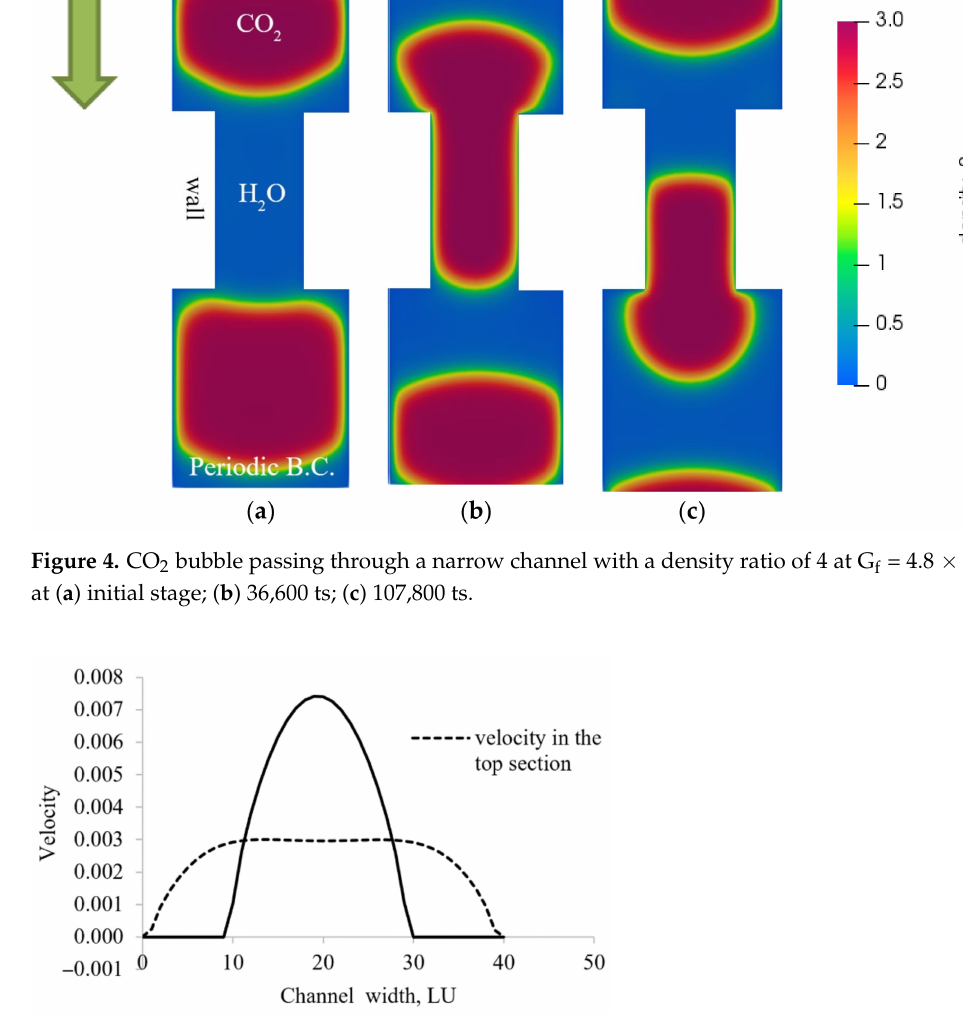
Figure 5. The bubble velocity profile at narrow and wide sections of the channel in a periodic pseudo-steady